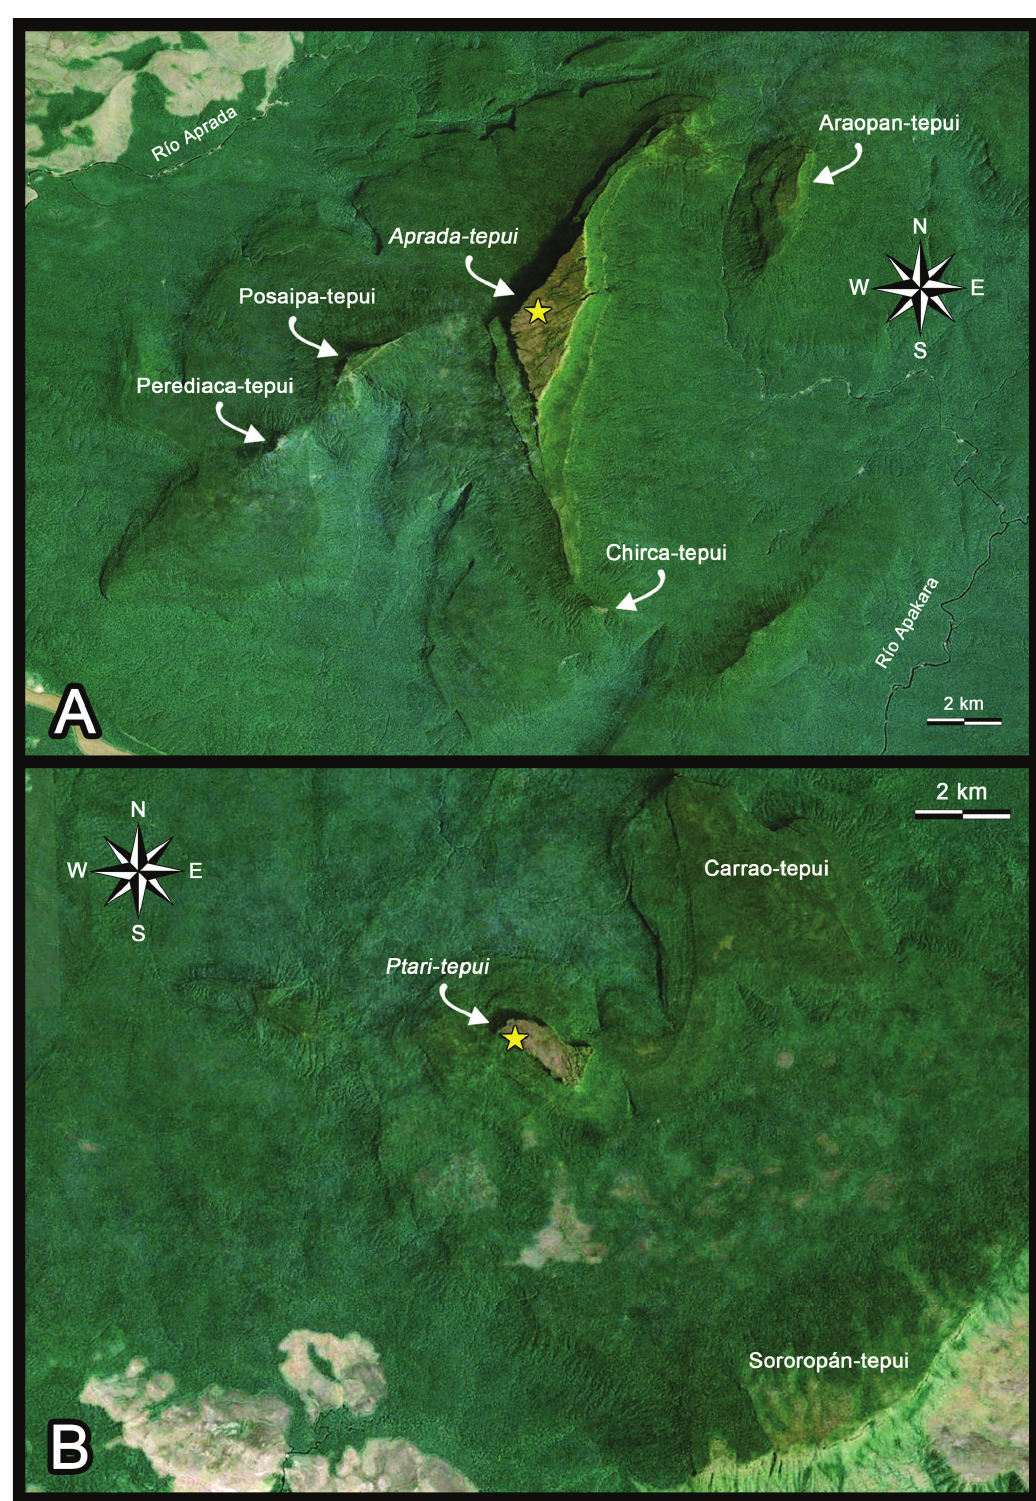
Fig. 6. A . Satellite map of the Aprada massif, showing the location of Aprada-tepui and neighbouring smaller table mountains. Yellow star indicates the type locality of Pristimantis jamescameroni. B . Satellite map of the Ptari massif, showing the location of Ptari-tepui and neighbouring mountains. Yellow star indicates the type locality of Pristimantis imthurni . Satellite maps © Google